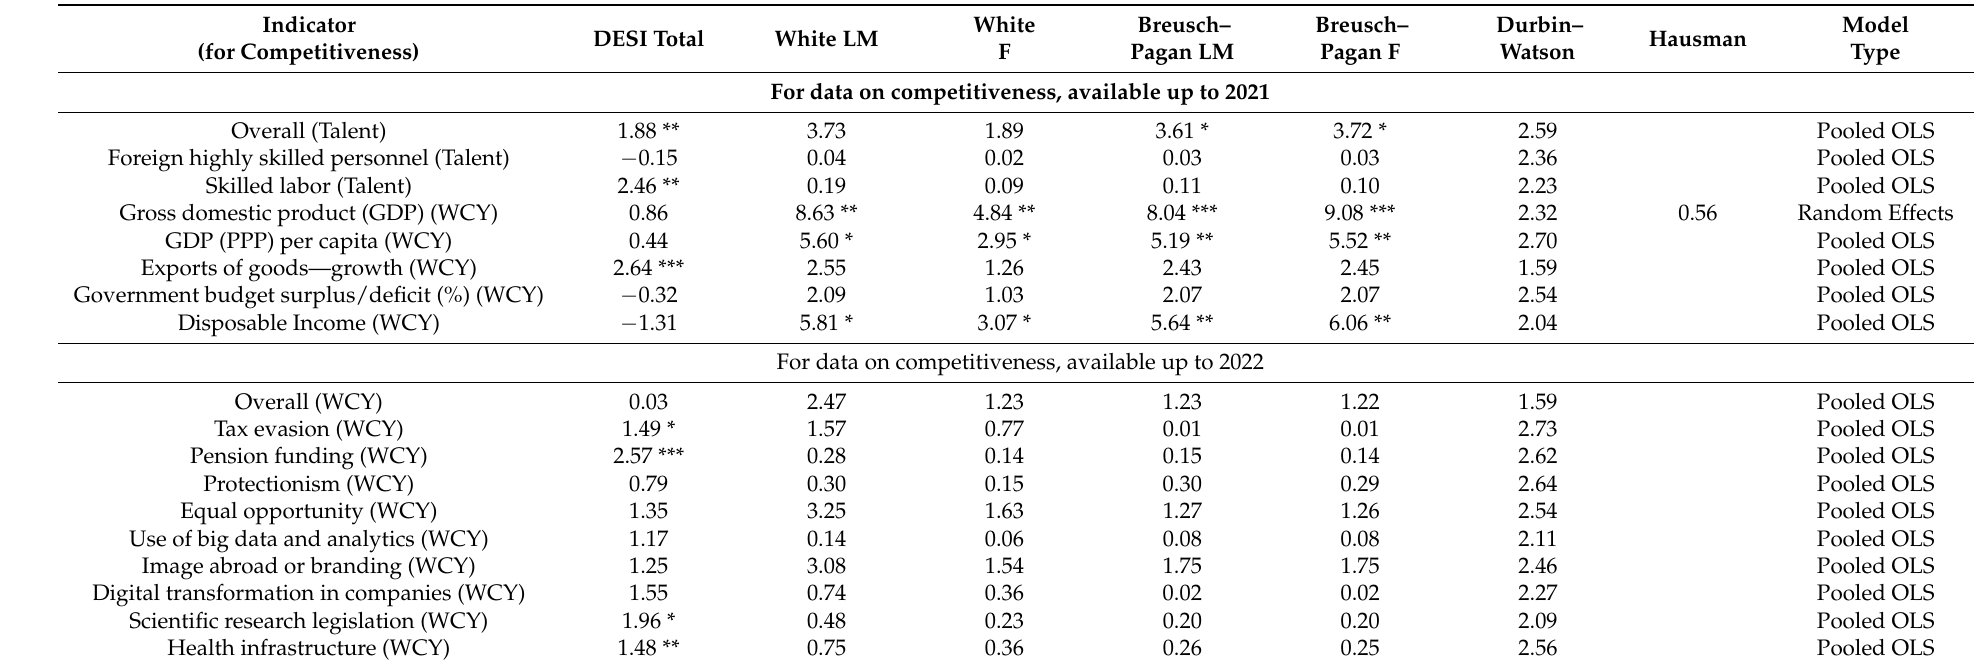
Table 3. Results for the scenario when the DESI total is considered for Central and Eastern European